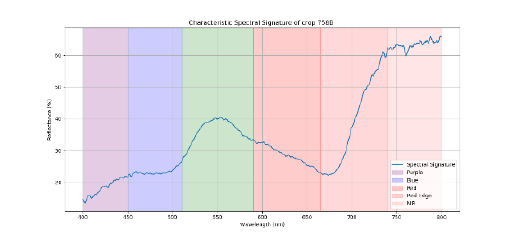
Figure 6. Average spectral signature of crop 758B